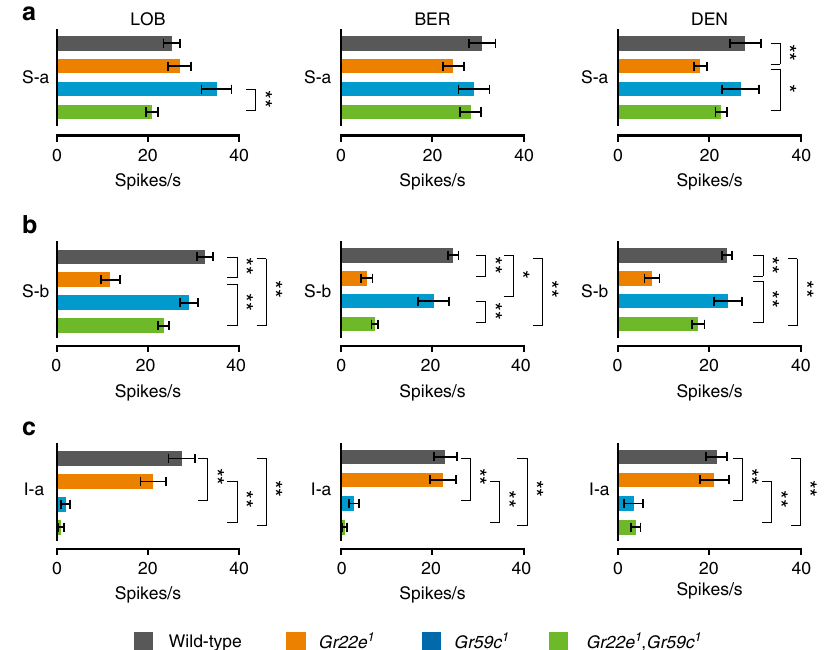
Fig. 5 Effect of Gr22e and Gr59c mutation on S-a sensilla. Mean response of S-a sensilla of the indicated genotype to 1 mM stimulations with LOB a , BER b , and DEN c . n = 6 – 54. ANOVAs followed by Tukey or Dunnett T3 post hoc tests or Kruskal − Wallis tests followed by Mann − Whitney U post hoc tests as appropriate. All data are presented as means ± S.E.M. The asterisks indicate statistically signi fi cant differences (* p < 0.05, ** p <